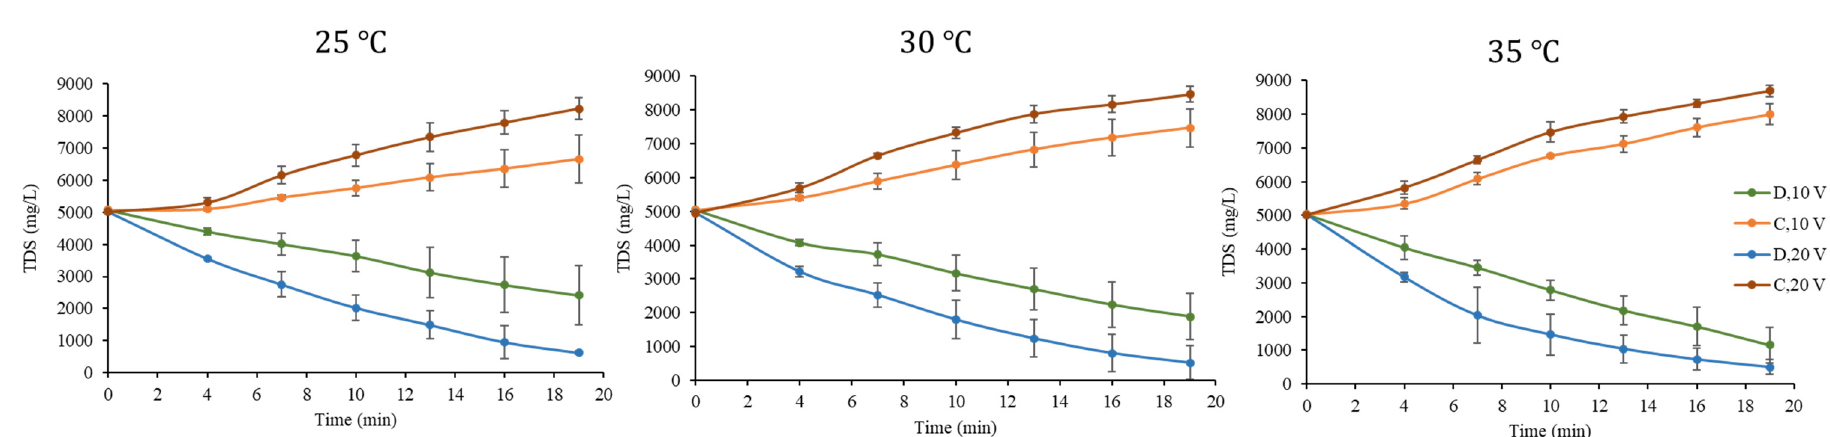
Figure 5. The evolution of the TDS in tests of 5000 mg/L TDS.